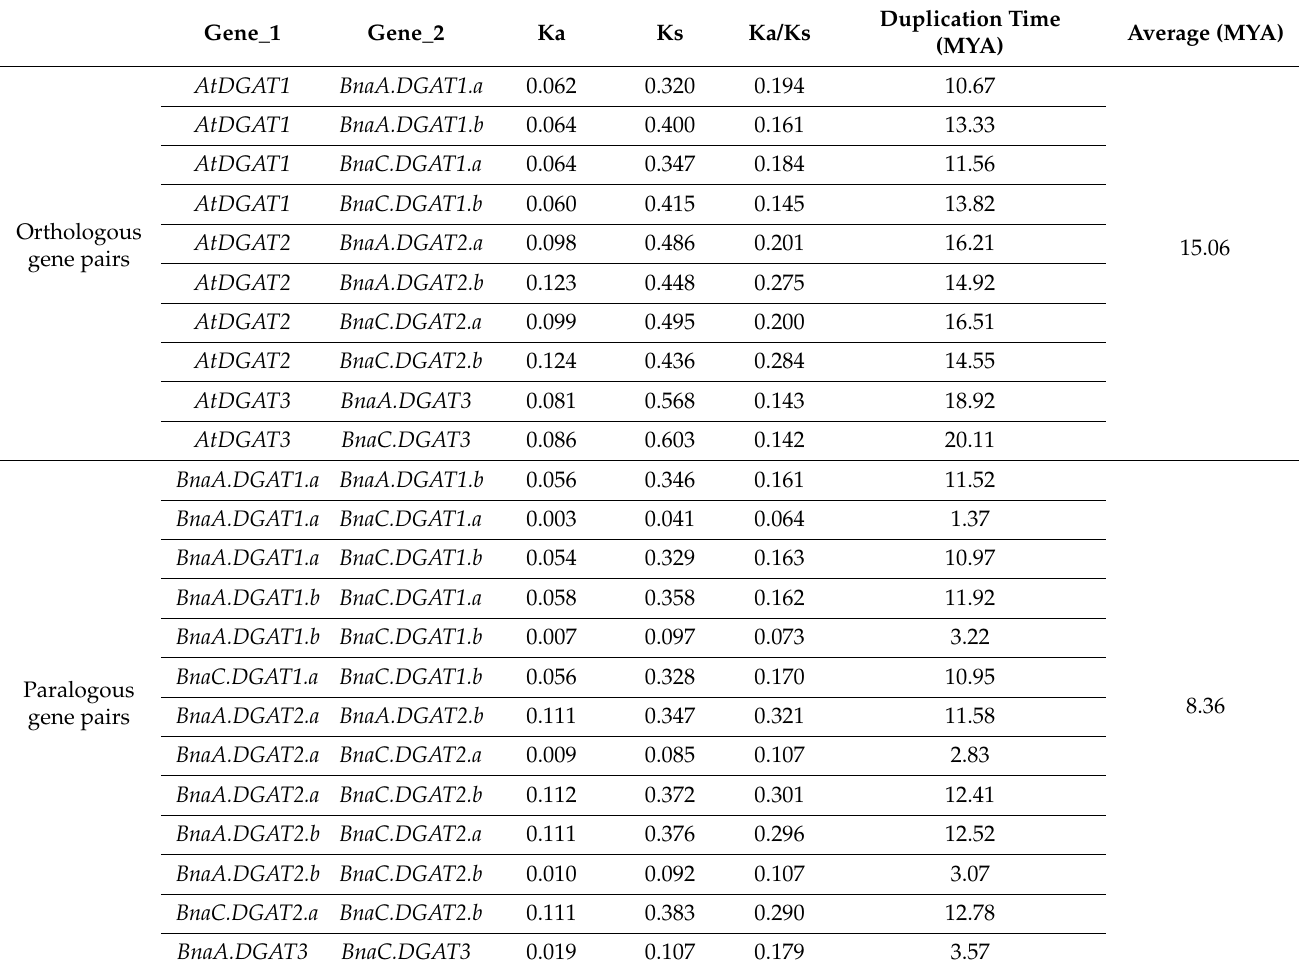
Table 3. Ks/Ka values between BnaDGAT and their paralogous gene pairs in Brassica napus and their orthologous gene pairs in Arabidopsis